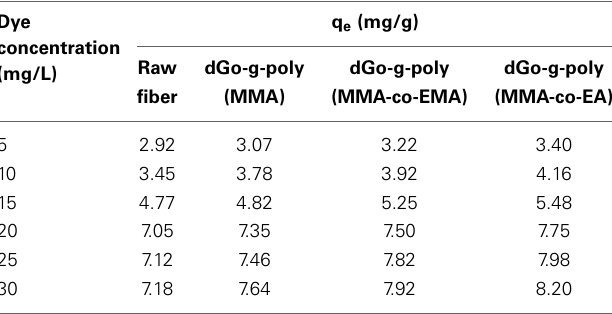
Table 4 | q e values for dye adsorption of raw, MMA grafted, MMA-co-EMA, and MMA-co-EA grafted Grewia optiva